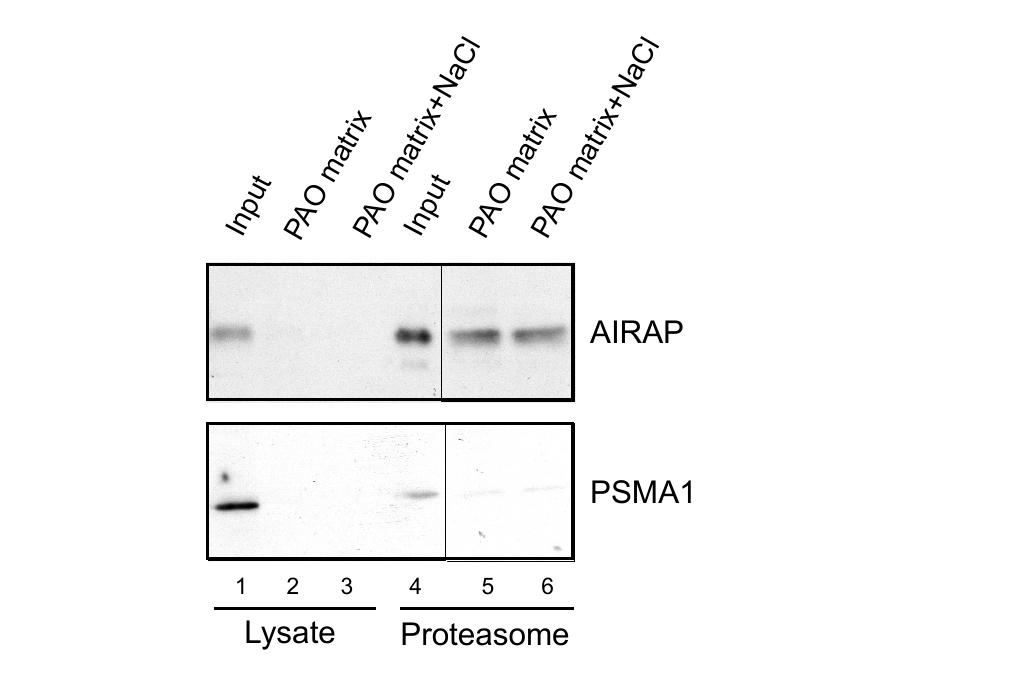
Figure 3. Endogenous proteasomal AIRAP binds arsenite. Cell lysates acquired from arsenite- treated cells were incubated with a PAO matrix. AIRAP and 20S proteasomal content (PSMA1) were evaluated by immunoblot (lanes 1–3). Alternatively, PAO matrix binding was performed using soluble proteasomes purified from arsenite-treated cells (lanes 4–6). Where indicated, PAO matrix was washed with high salt to evaluate impact on PAO binding (lanes 3 and 6).